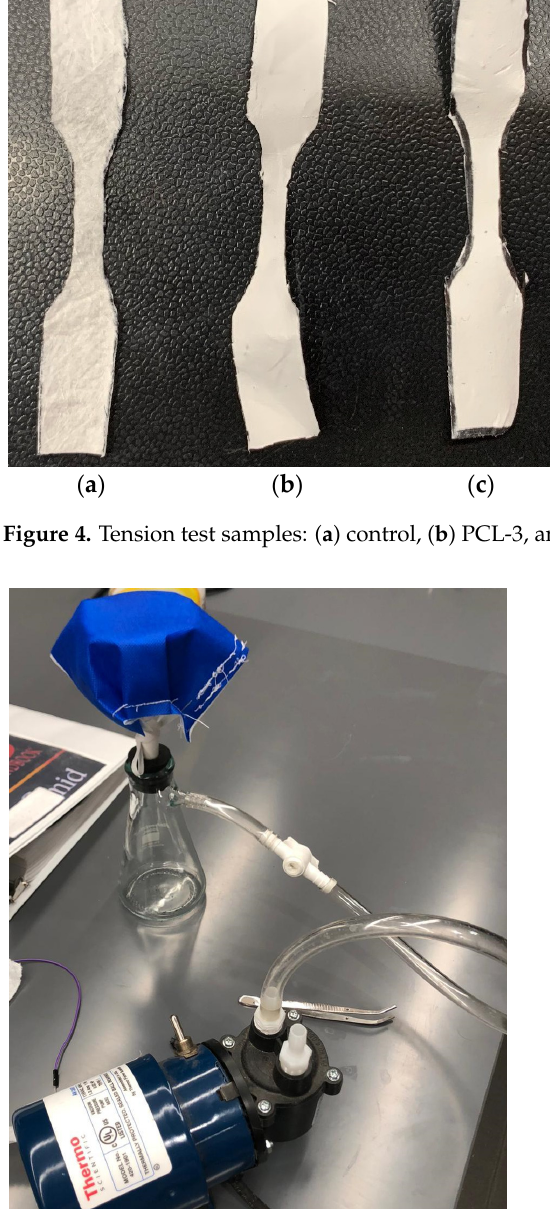
Figure 4. Tension test samples: ( a ) control, ( b ) PCL-3, and ( c ) PCL-10.